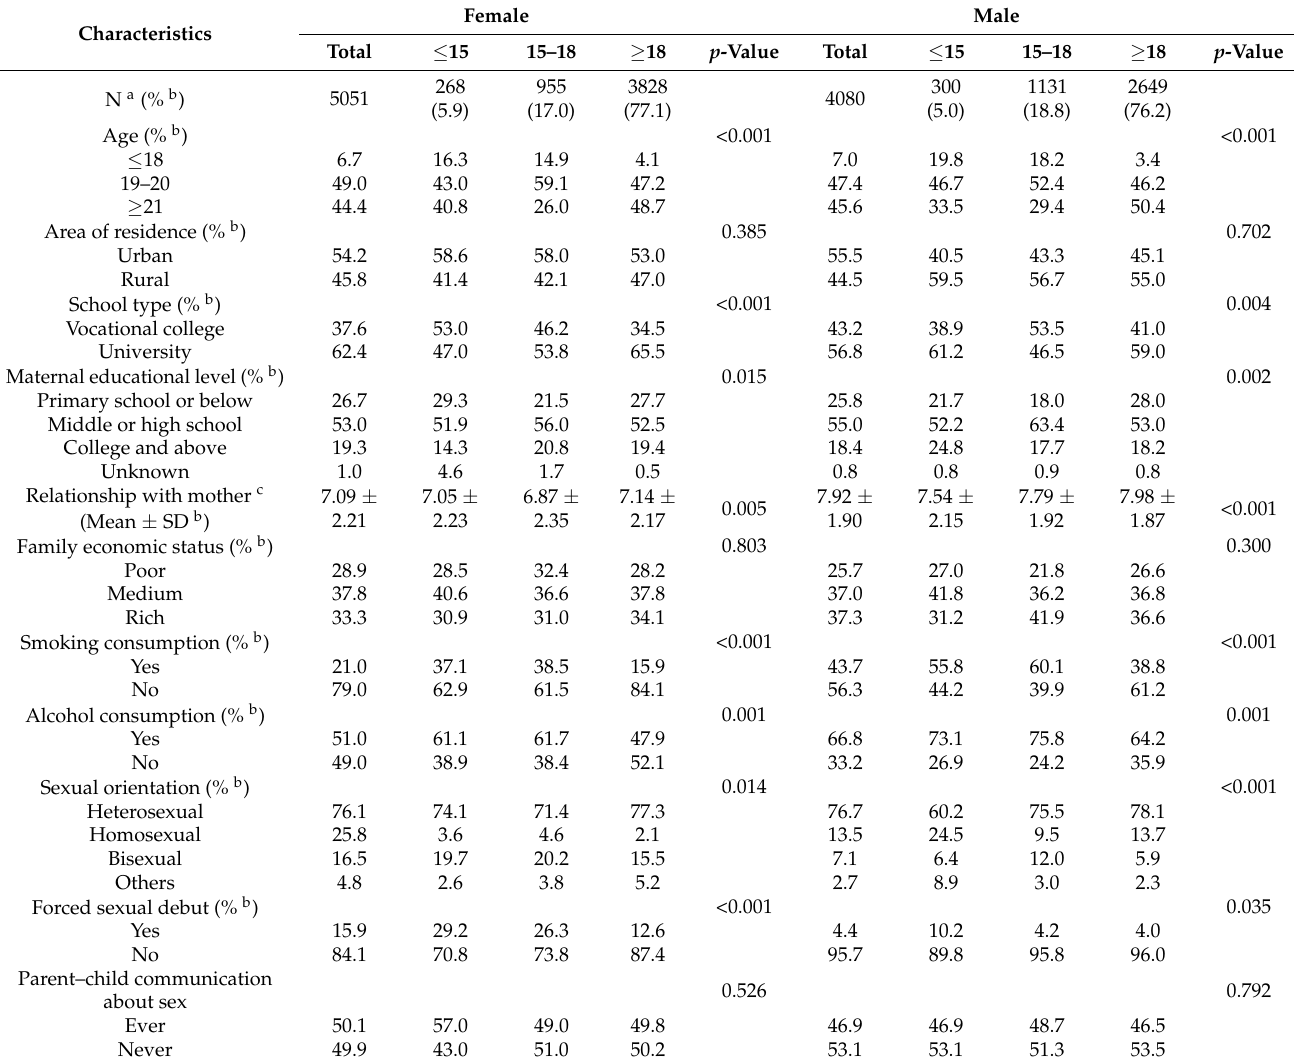
Table 1. Basic characteristics of participants by sex and age at sexual debut (N =